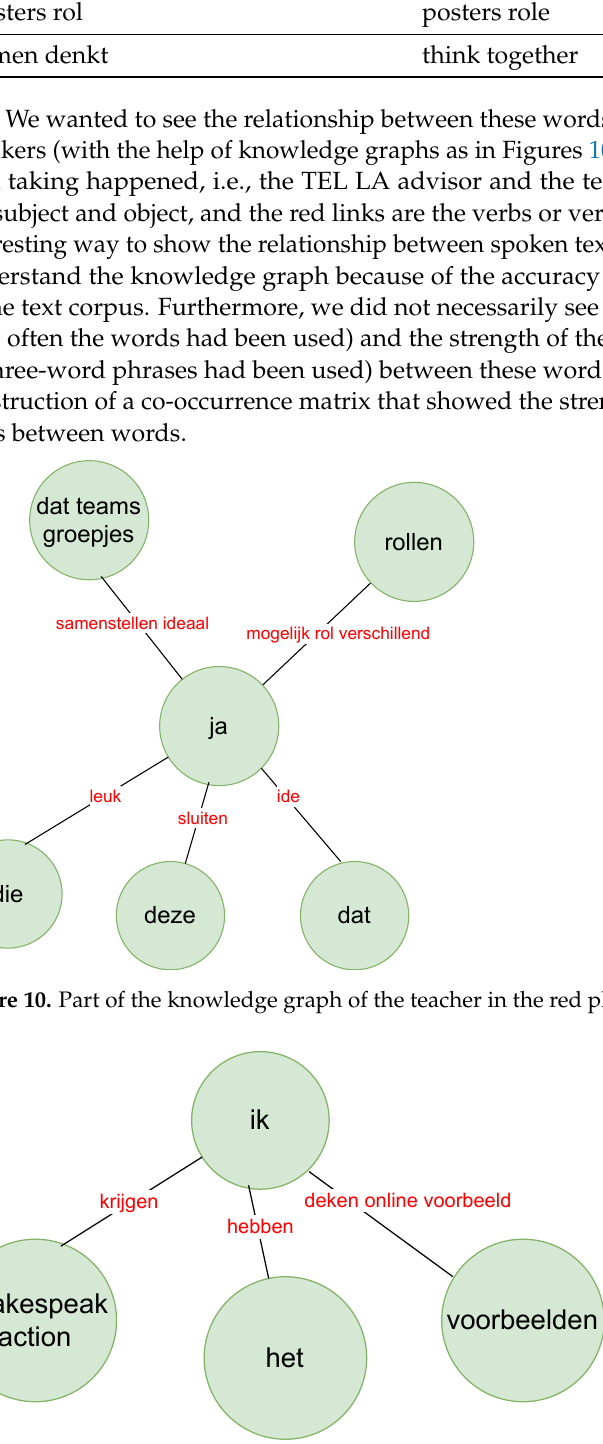
Figure 11. Part of the knowledge graph of the TEL LA advisor in the red phase (zoomed